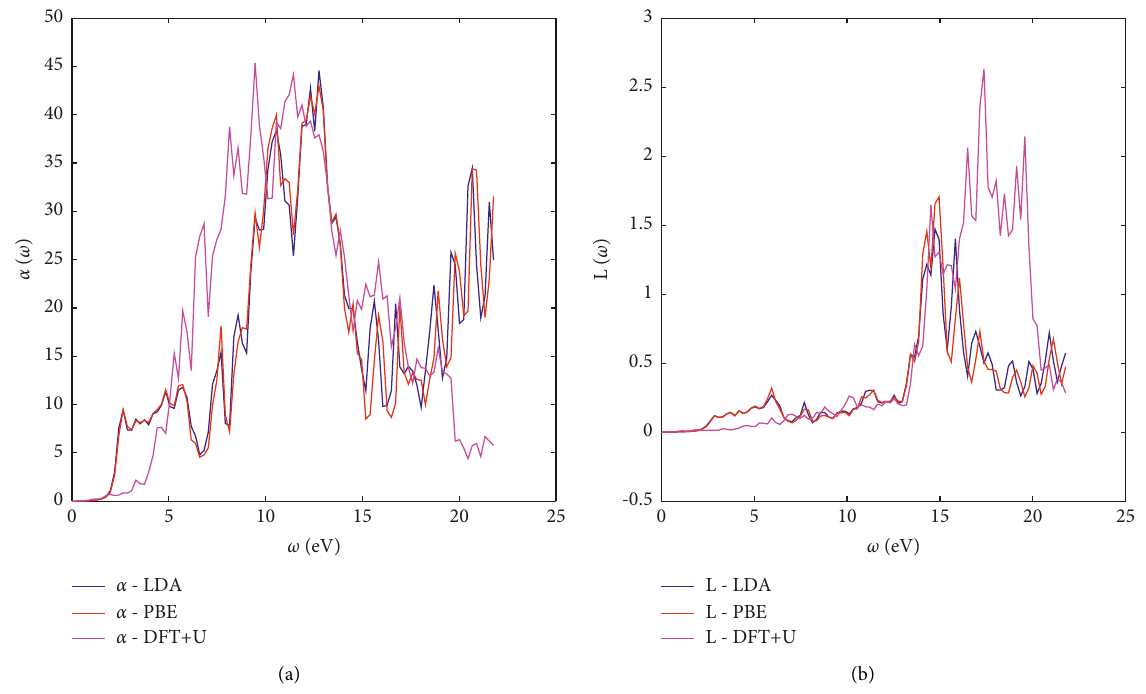
Figure 8: (a) Absorption coefficient and (b) energy loss of CeO